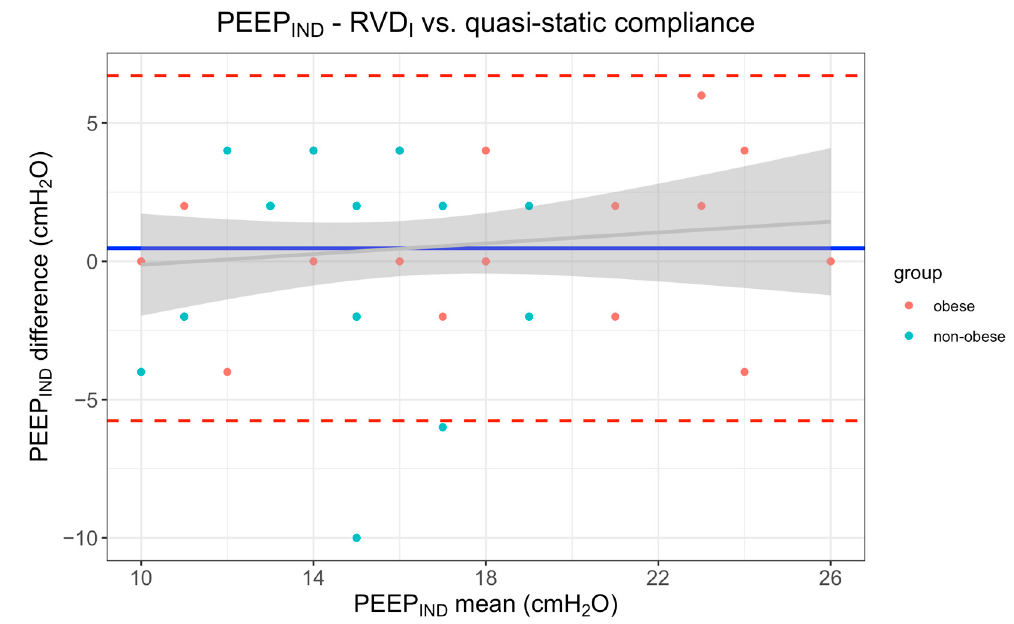
Figure 3. Bland–Altman plot between PEEP IND using regional ventilation delay index (RVD I ) and PEEP IND determination using quasi-static compliance as calculated by the least squares method (C Qstat ). Bias was 0.5 ± 3.18 cm H 2 O and did not differ between obese and non-obese patients (0.7 ± 2.7 cm H 2 O vs. 0.2 ± 3.7 cm H 2 O, p = 0.99). Additional Bland-Altman plots comparing RVD I , GI and compliance-based methods can be found in the Supplemental Material.